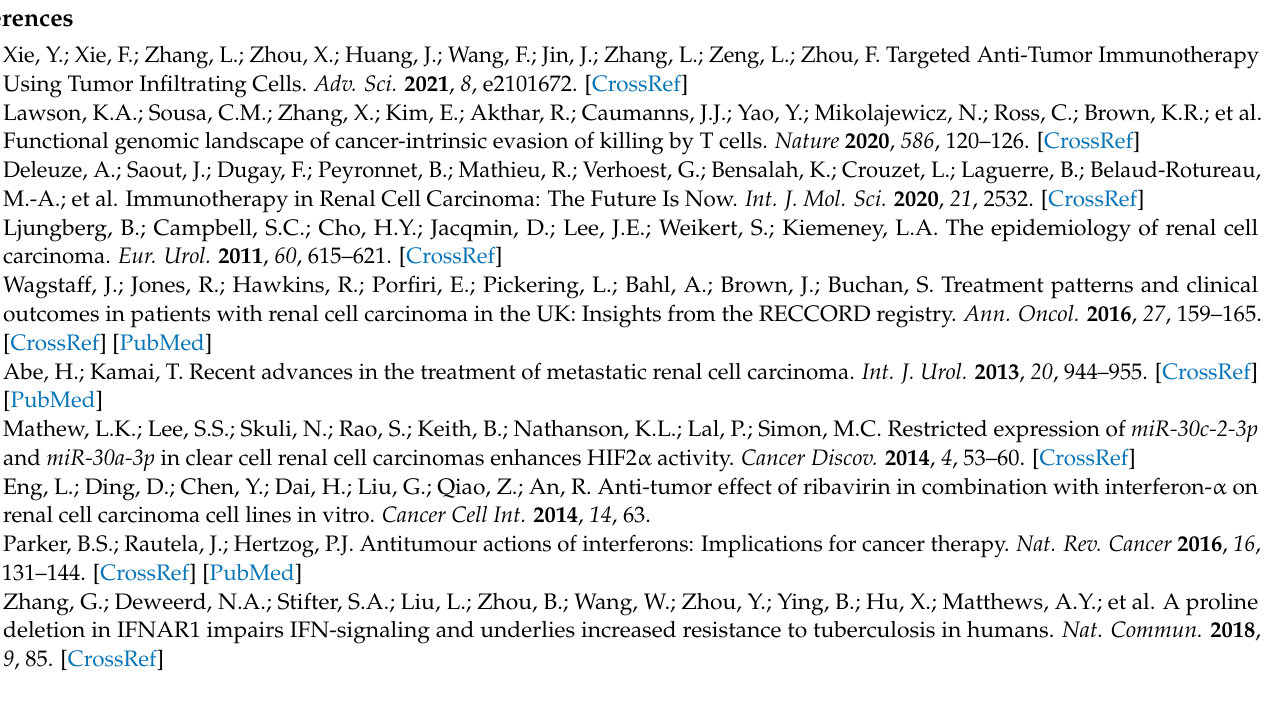
Figure S2: Supplementary figures for mIHC, Western Blot and IFNAR1 expression in CM-025 cohort; Table S1: core CTL-related genes; Table S2: quantification of CD4 CD8